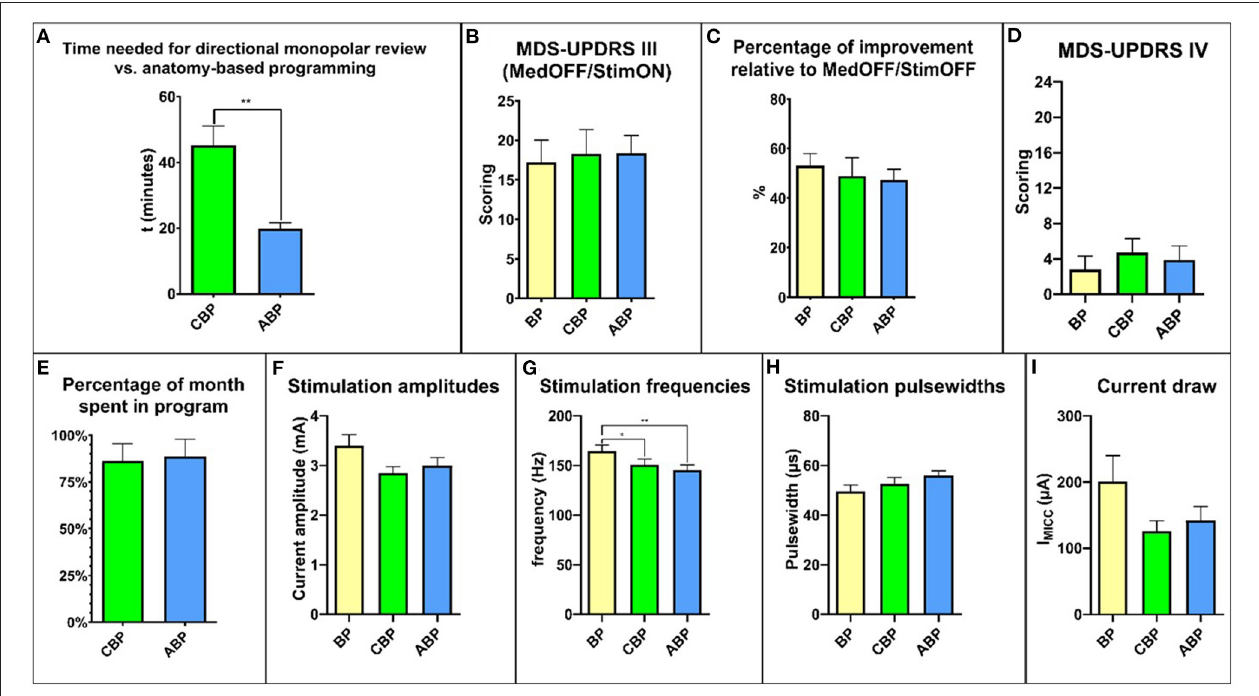
FIGURE 2 | Overview of the relevant study results. (A) time needed for programming. (B) MDS-UPDRS III scores. (C) percent improvement relative to MedOFF/StimOFF. (D) MDS-UPDRS IV. (E) time spent in the program during the respective month of the study. (F) stimulation amplitudes. (G) stimulation frequencies. (H) stimulation pulse widths. (I) current draw. MDS-UPDRS, Movement Disorders Society Unified Parkinson’s Disease Rating